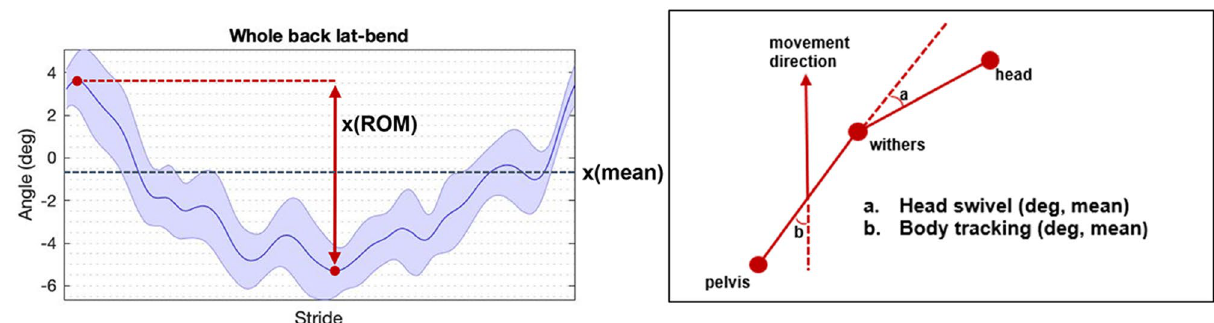
Figure 2. The left graph illustrates how stride mean and range of motion (ROM) were calculated, shown on an example of a lateral bending stride curve (blue line indicates the mean, shaded area the standard deviation). The right graph illustrates the variables a ‘Head swivel’ and b ‘Body tracking’, with angles indicated on the side where they are positive, e.g. head placed to the right of the long axis of the